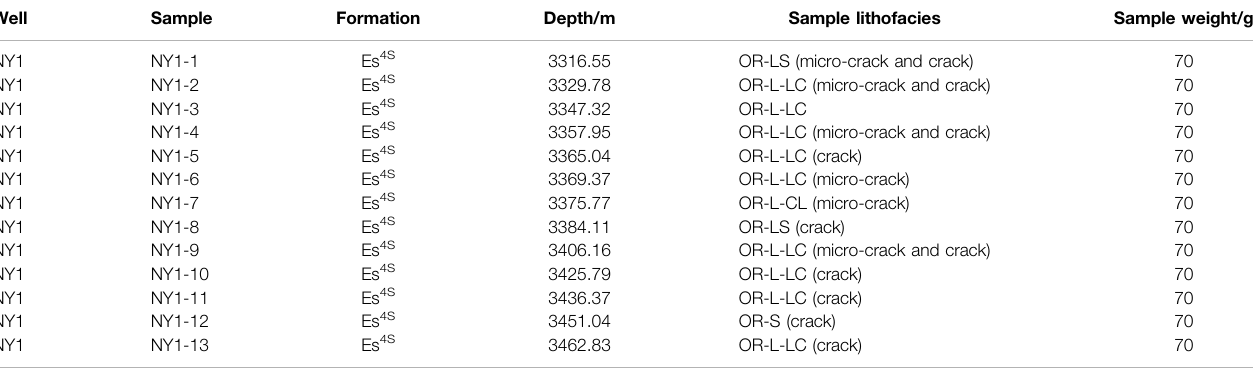
TABLE 4 | NMR experimental sample information sheet. See Figure 1 for the well location. Well